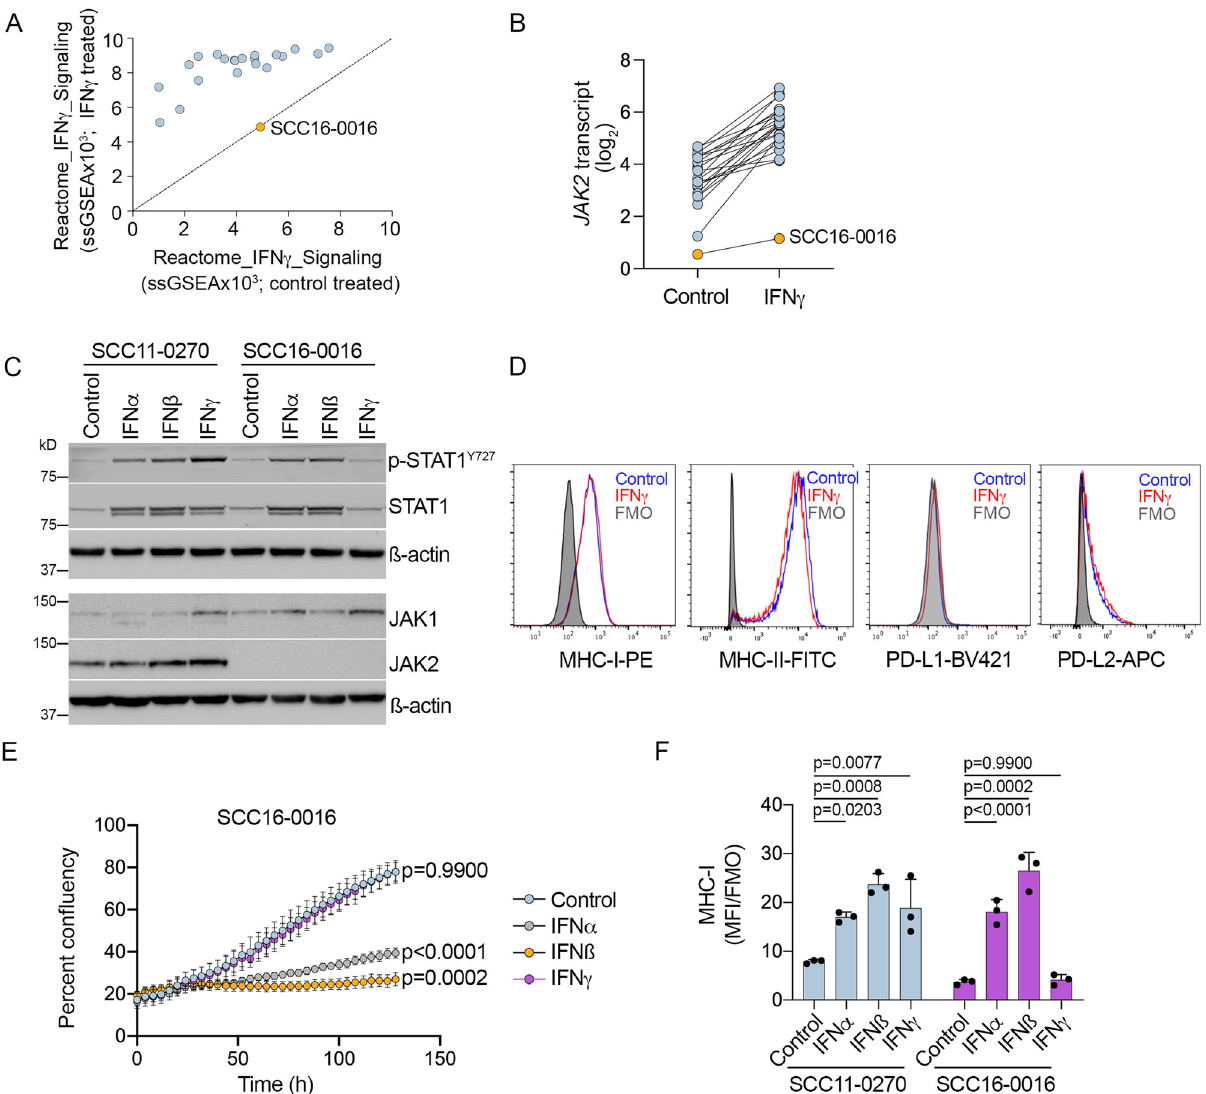
Fig. 1 | IFN γ response in PD1 PROG cell lines. A ssGSEA scores for the Reacto- me_Interferon_Gamma_Signaling gene set in 22 PD1 PROG melanoma cell lines treated with BSA control ( x -axis) or 1000 U/ml IFN γ ( y -axis) for 24h. The SCC16- 0016 PD1 PROG did not respond to IFN γ stimulation and is highlighted. B JAK2 transcriptexpressioninmatchedBSAcontrolandIFN γ -treatedPD1PROGcelllines ( n =22). C Accumulation of phosphorylated STAT1 (p-STAT1 Y727 ), STAT1, JAK1, and JAK2 in the SCC11-0270 (responded to IFN γ ) and SCC16-0016 (did not respond to IFN γ ) PD1 PROG celllines treatedwith BSA control, IFN α , IFN β , or IFN γ (allat1000 U/ml) for 24h. D Representative histograms showing levels of MHC-I, MHC-II, PD- L1,andPD-L2expressioninSCC16-0016celllineafterBSAcontrol(blue)or1000U/ mlIFN γ (red)treatmentfor72h.Fluorescenceminusone(FMO)controlsareshown as shaded histograms. E Representative proliferation curve of SCC16-0016 cells,